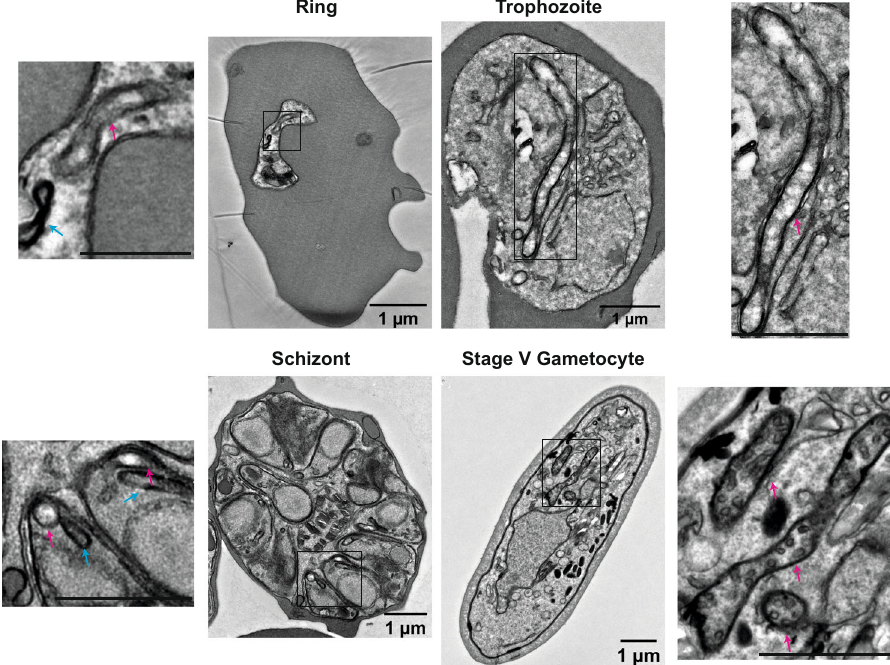
Fig. 1 Representative electron micrographs of Plasmodium falciparum blood stages. Enlarged sections show ultrastructural differences between the mitochondrion (magenta arrow) in ABS parasites and gametocytes. The mitochondrion presents as an electron-lucent, acristate structure during ABS development, while the gametocyte mitochondrion appears electron-dense and packed with tubular cristae. Also note the close proximity of the four- membrane-bound apicoplast (light-blue arrow) in ring- and schizont-stage parasites. Scale bar ring-stage parasite higher magni fi cation crop, 0.5 μ m; all other scale bars, 1 µ m. In total, three independent ABS samples and three independent gametocyte samples were imaged and observations were consistent across